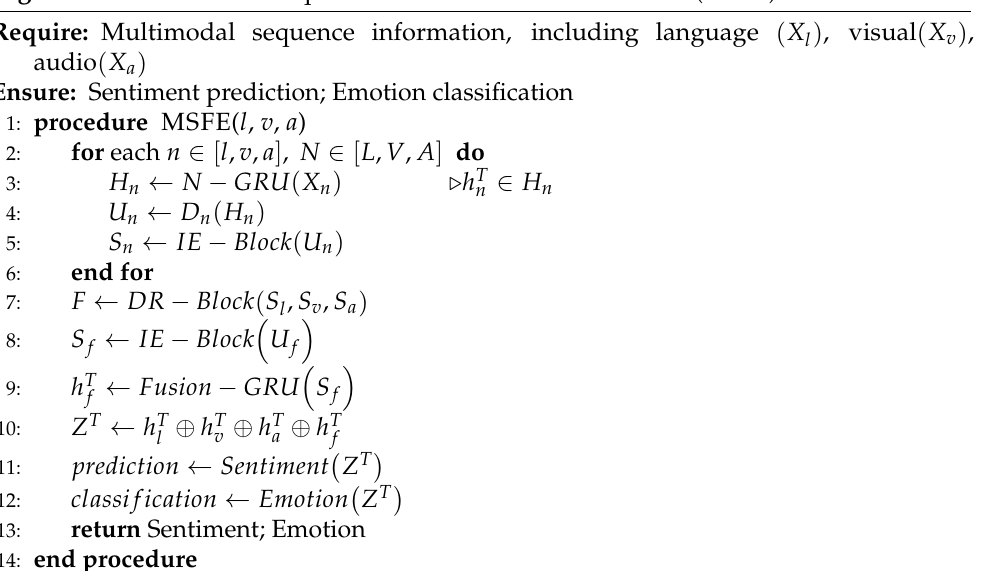
Algorithm 1 Multimodal Sequence Feature Extraction Network